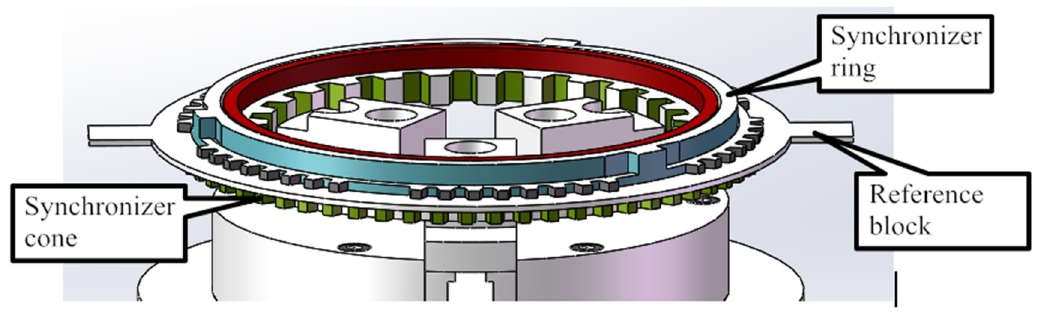
Figure 7. Installation schematic diagram of the synchronizer on the detection platform.